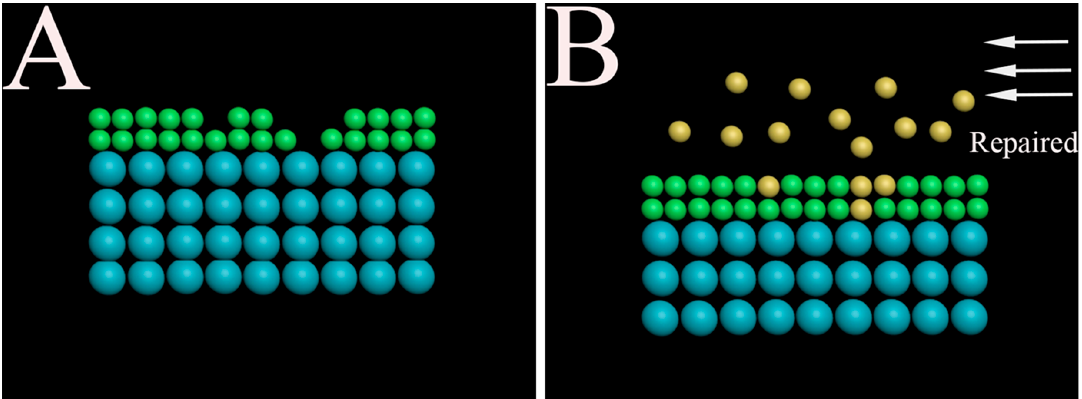
Figure 3. Pore-size distribution of ceramic membrane with 5 wt % solid content.